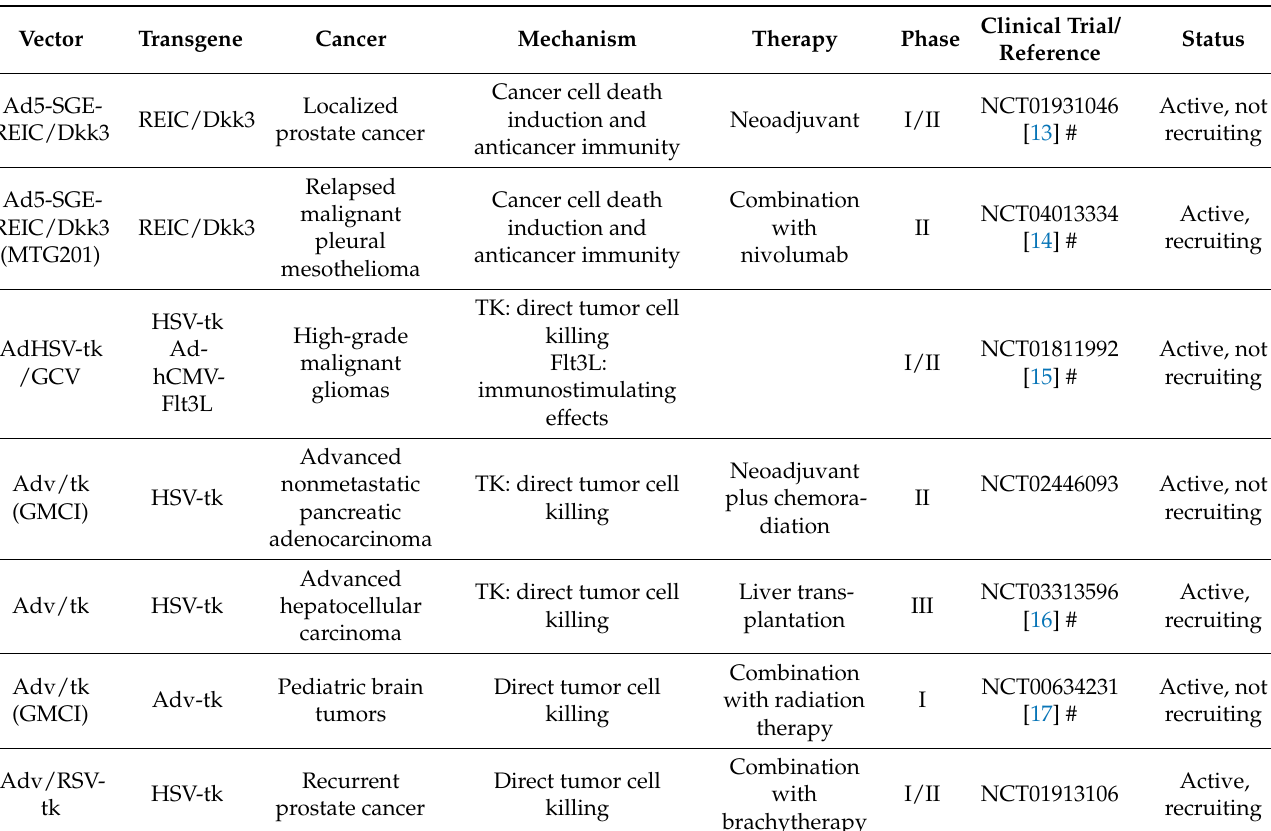
Table 1. Clinical trials using nonreplicating adenoviral vectors for cancer gene therapy.